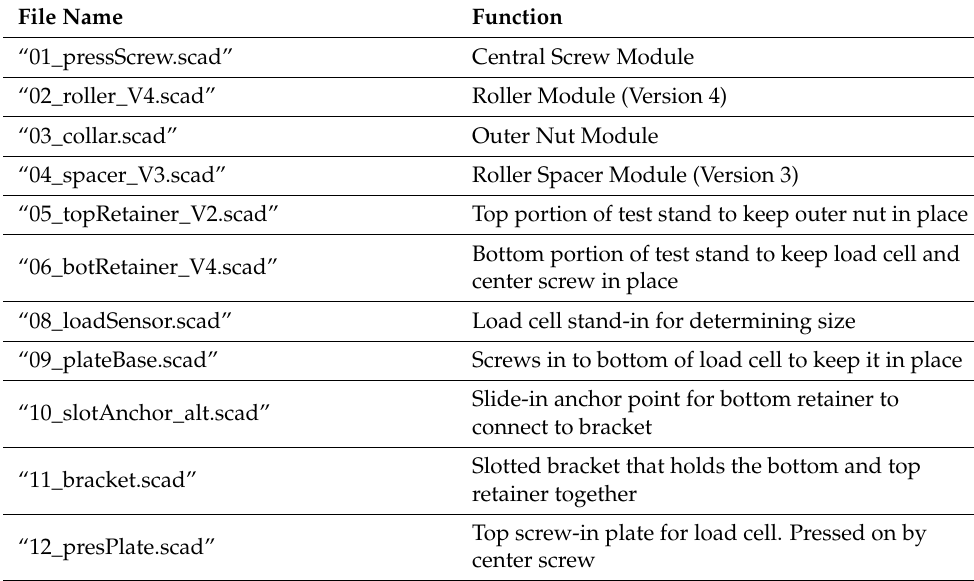
Table A1. File names and functions for the open source SCAD files.